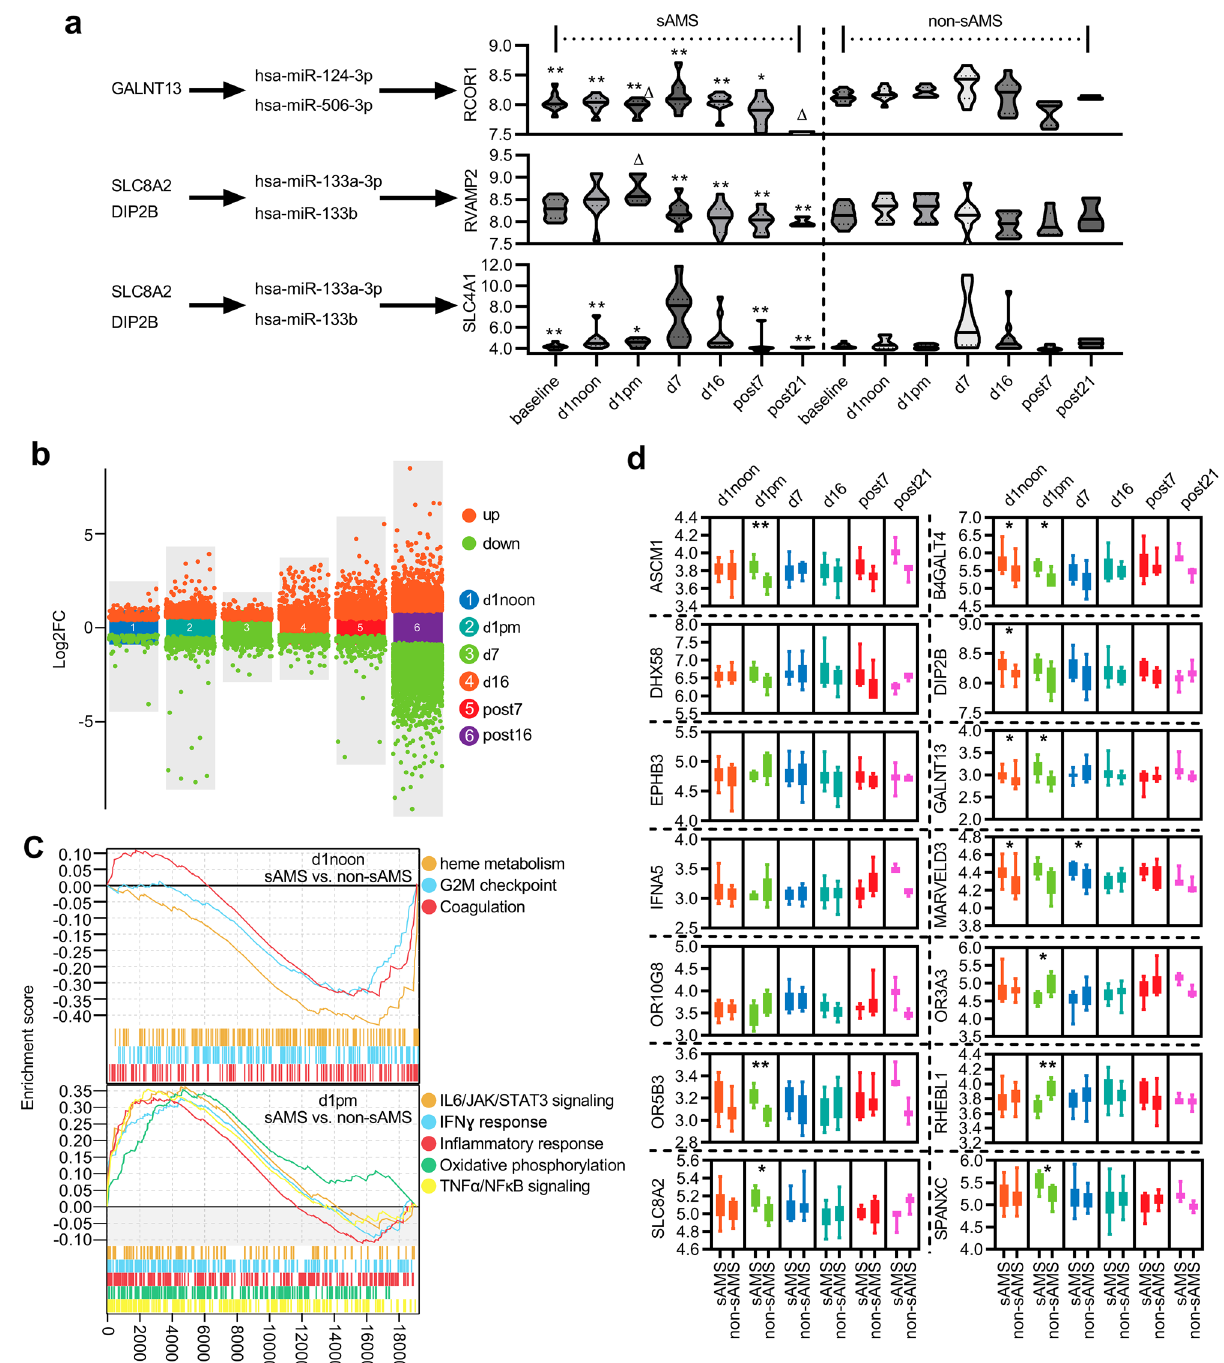
Figure 7. Changes of the featured genes and their miR targets in sAMS. ( a ) Timeline changes of miR targets. The miR products hsa-miR-124-3p/506-3p of GALNT13 mediated the expression changes in their target RCOR1 in sAMS, which peaked at d7 (N = 9) and recovered at post21 (N = 3). Compared with post21, * P < 0.05, ** P < 0.01; in comparison with non-sAMS, ∆ P < 0.05 (Tukey’s multiple comparisons test). As the shared miR products of SLC8A2 and DIP2B, hsa-miR-133a-3p/133bregulate the expression of their targets, RVAMP2 and SLC4A1, which were upregulated at d1pm (N = 6) or d7 (N = 9). * P < 0.05, ** P < 0.01 vs. d1pm or d7. ∆ P < 0.05 vs. non-sAMS (Tukey’s multiple comparisons test). ( b ) Between-group changes of miR targets. ( c ) GSEA analysis. ( d ) Between-group changes of the 14 featured genes. The featured genes were compared in the relative expression level between subjects with (N = 9 (d1noon), 6 (d1pm), 9 (d7), 10 (d16), 7 (post7), 3 (post21)) and without sAMS (N = 10 (d1noon), 6 (d1pm), 9 (d7), 11 (d16), 7 (post7), 3 (post21)). Compared with non-sAMS, * P < 0.05, ** P < 0.01